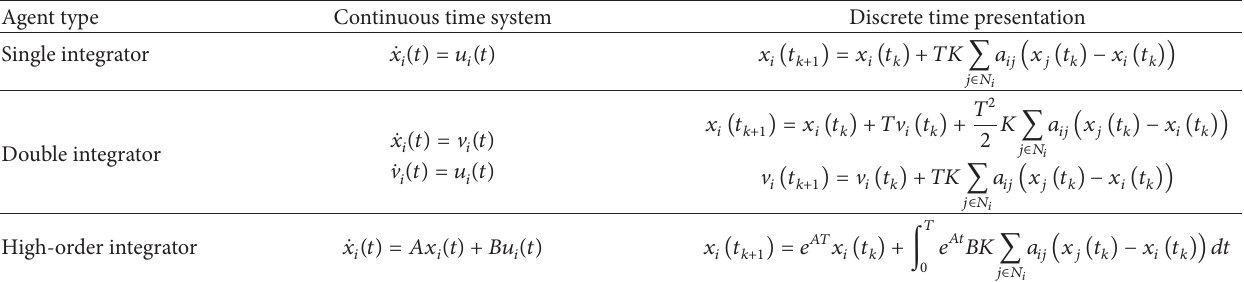
Table 1: Continuous time and discrete time presentations of agent dynamics.